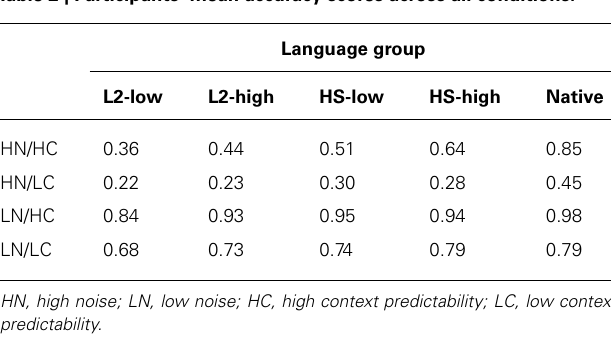
Table 2 | Participants’ mean accuracy scores across all conditions.